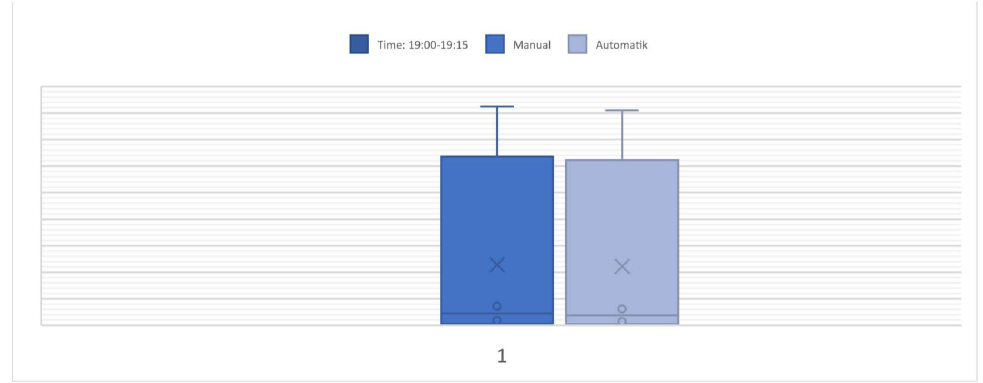
Figure 8. Difference between automatic and manual vehicle counts (time 21:10–21:25).